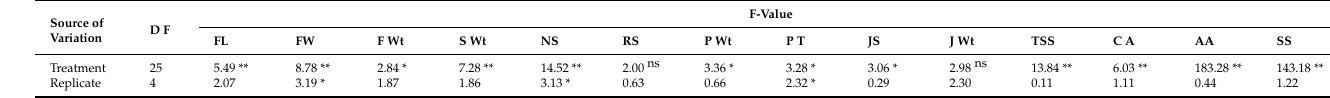
Table 6. Analysis of variation for various morphological and nutrient contents among and within the fruit source of C. sinensis